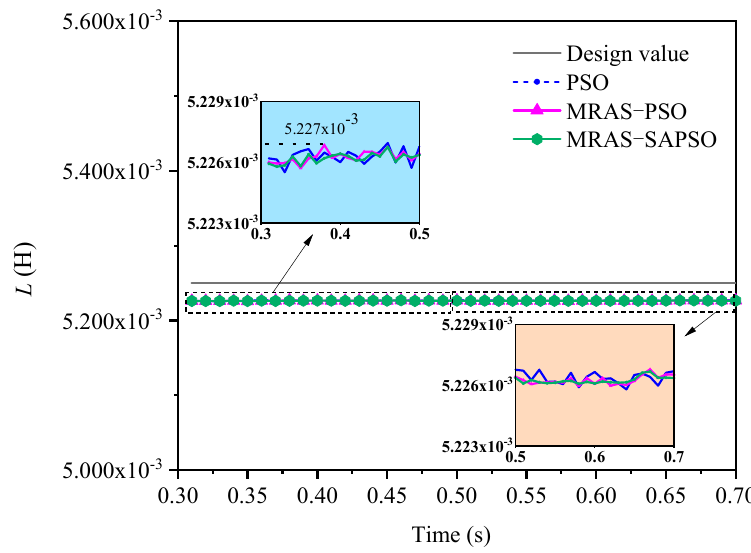
Figure 9. Resistance identification curve.